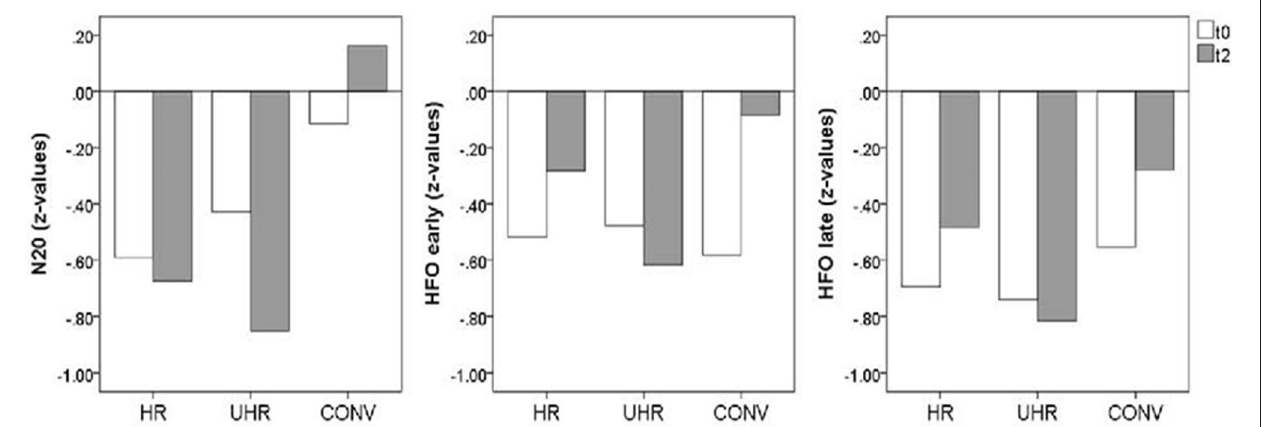
FIGURE 4 | Mean SEP amplitudes ( z -values) for the cannabis non-user subjects from the high-risk (HR, n = 10), ultra high-risk (UHR, n = 9), and converter (CONV, n = 7) groups at baseline (t0) and follow-up